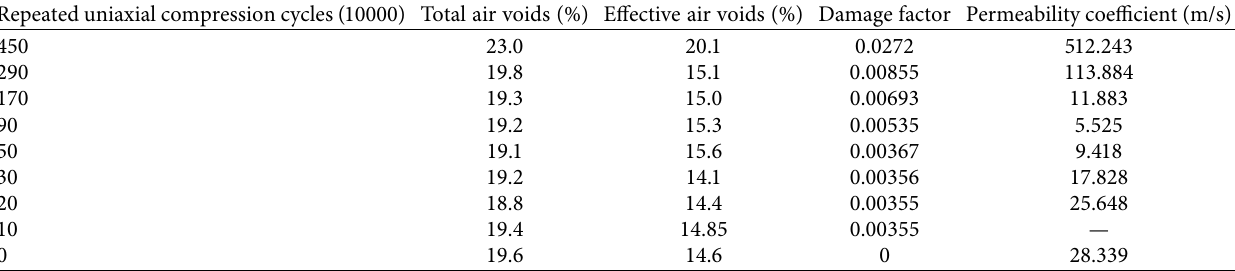
Table 8: Repeated uniaxial compression test results with non-seepage field.